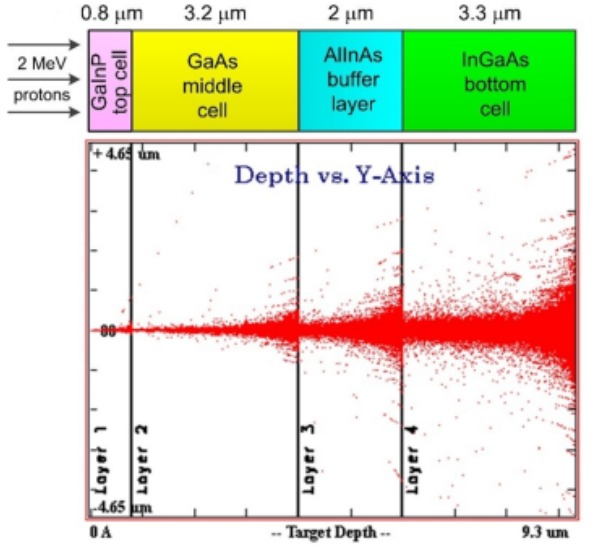
Figure 1. Track distribution of 2 MeV protons in IMM3J solar cells.